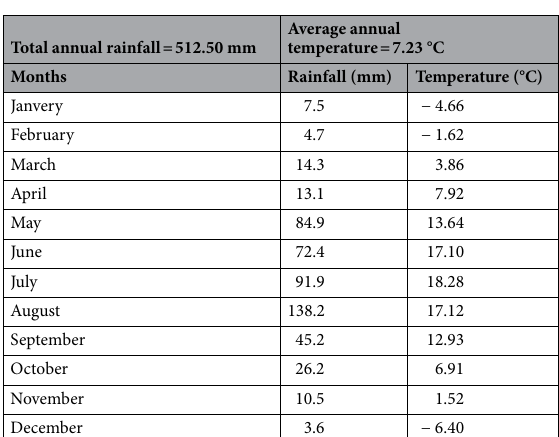
Table 2. Climatic conditions of the study site during 2020. Climatic data contains total monthly rainfall and average monthly temperature.